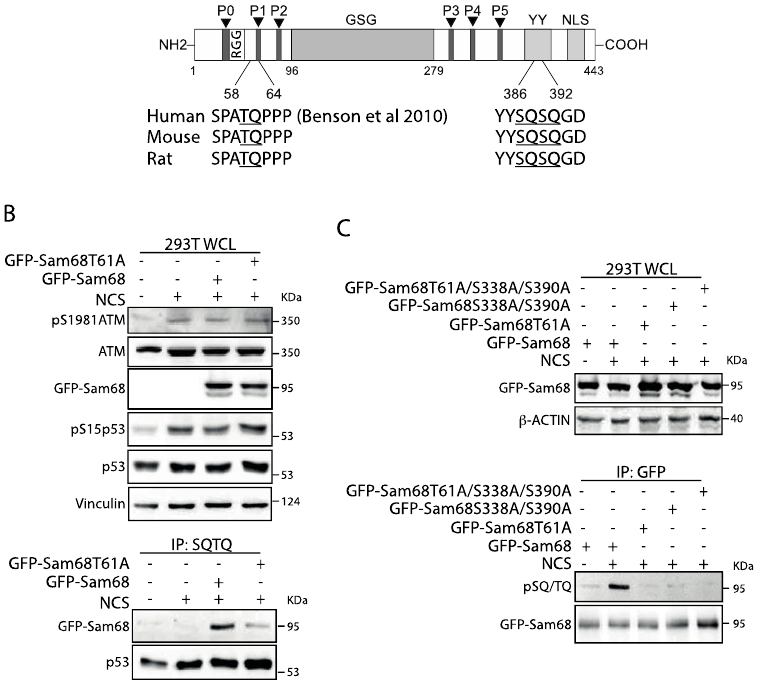
Figure 3. Preferential phosphorylation of T61 on Sam68 by ATM kinase activation upon DDR induction. ( A ) Schematic representation of putative serine and threonine residues on Sam68 phosphorylated by ATM kinase. ( B ) HEK293T cells were transiently transfected with fusion protein with either wild-type, GFP-Sam68 WT , or mutants lacking threonine 61 phosphorylation sites, GFP-Sam68 T61A , as indicated, and treated or not with NCS (500 ng/mL) for 1 h. Representative western blot of total protein extracts (whole-cell lysate, WCL) and protein extracts subjected to immunoprecipitation assay using anti-SQ/TQ antibody (IP: SQTQ) and immunoblotted with the indicated antibodies. Vinculin was evaluated as loading control of total protein extracts. ( C ) HEK293T were transiently transfected with either wild-type GFP-Sam68 WT or mutants lacking TQ/SQ phosphorylation sites, as shown in the schematic representation in ( A ), and treated, or not, with NCS (500 ng/mL) for 1 h. Representative western blot of total protein extracts (whole-cell lysate, WCL) and protein extracts subjected to immunoprecipitation assay using anti-GFP (IP: GFP) antibody and immunoblotted with the indicated antibodies. β -actin was evaluated as loading control of total protein